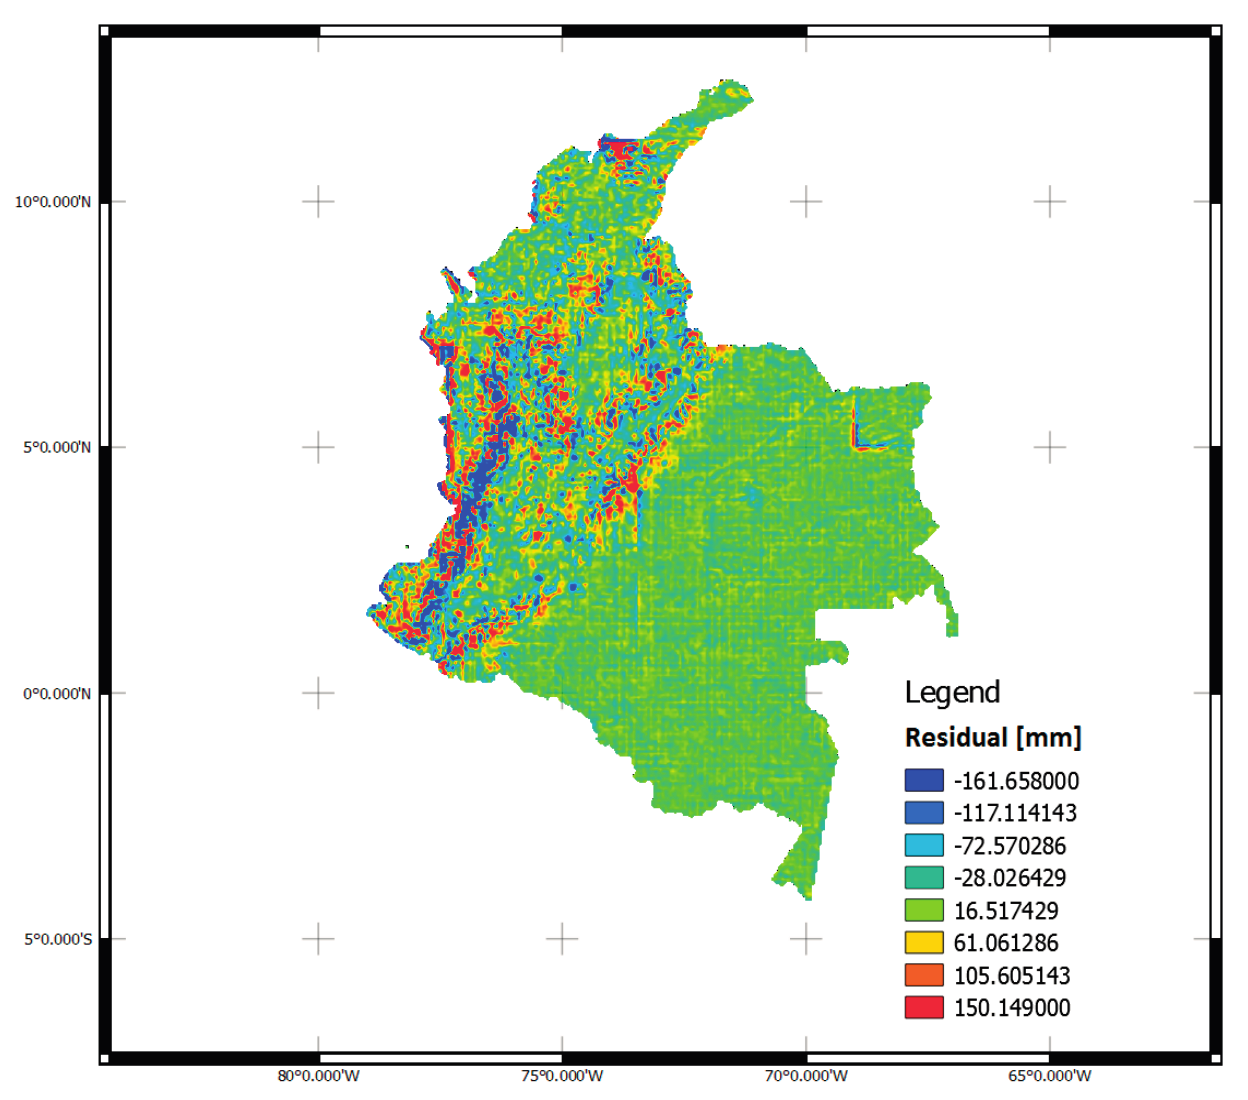
Figure 4. Residual of the Geographically Weighted Regression ( GWR ) method, i.e. , the difference between remotely sensed and explained precipitation across Colombia with CHIRP